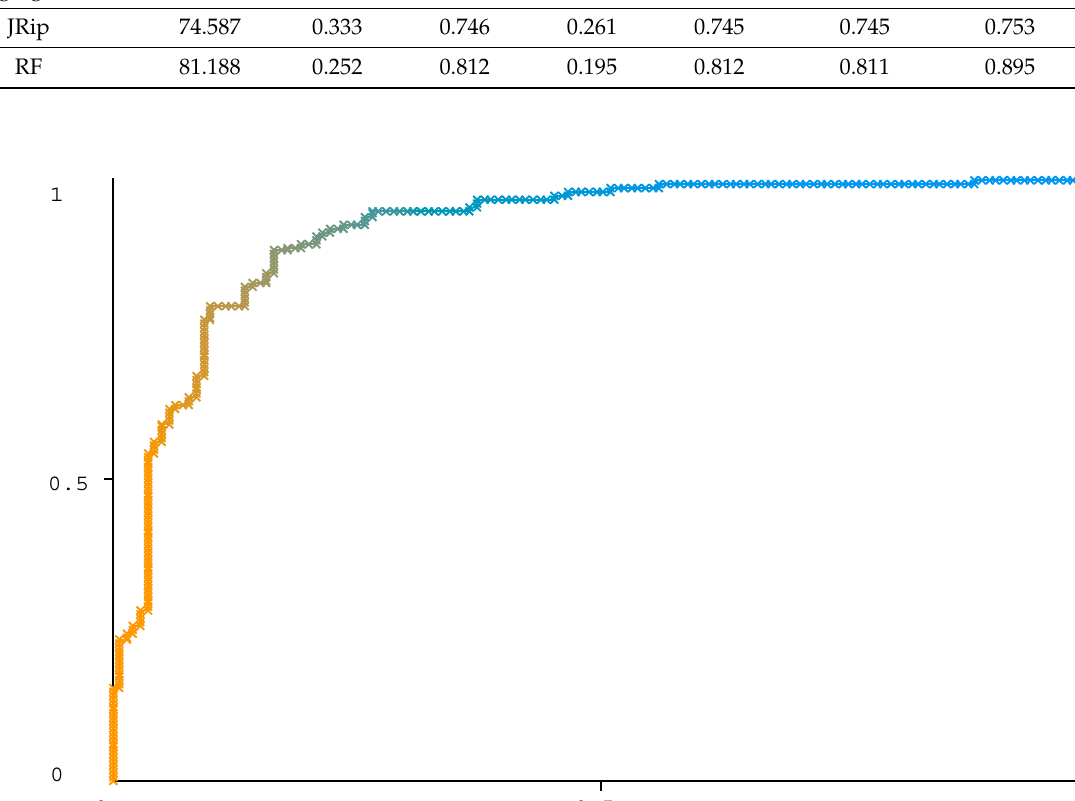
Figure 9. ROC curve of the bagging with LR meta classifier using the ReliefF attribute evaluation set.